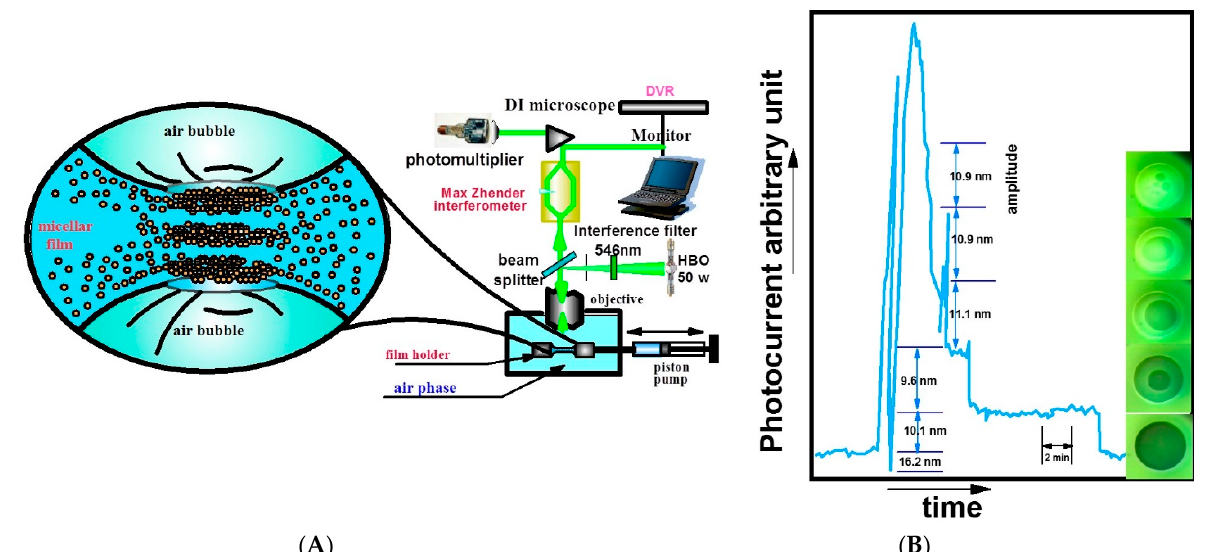
Figure 6. ( A ) Sketch of the optical arrangement to monitor the micellar foam’s multiple stepwise thinning phenomena using the film’s capillary force balance, via the ring method. ( B ) Foam film' thinning interferogram of the micellar solution of cetyltrimethylammonium bromide (CTAB) at a concentration of 2.10 − 1 M depicts the stepwise thickness transitions [31]. Reprinted with permission from [31]. Copyright 2022 Elsevier.